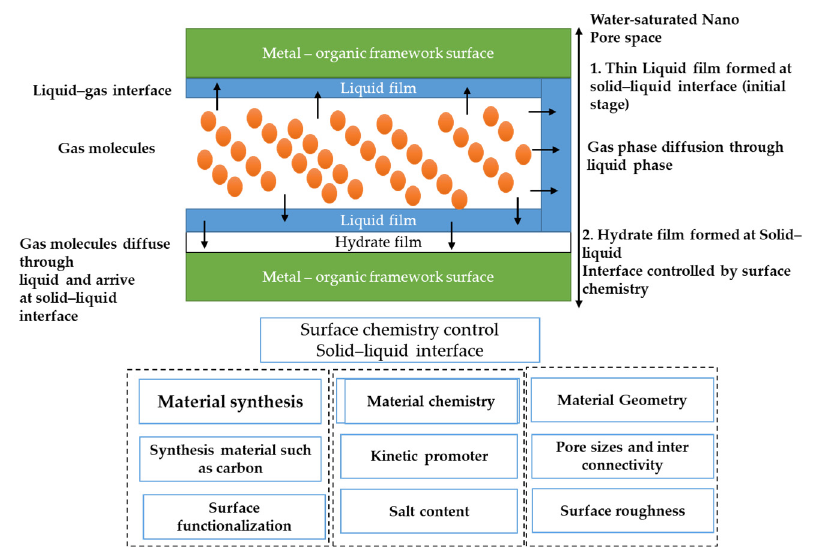
Figure 12. Proposed overview of factors affecting surface chemistry during hydrate formation in pore spaces.